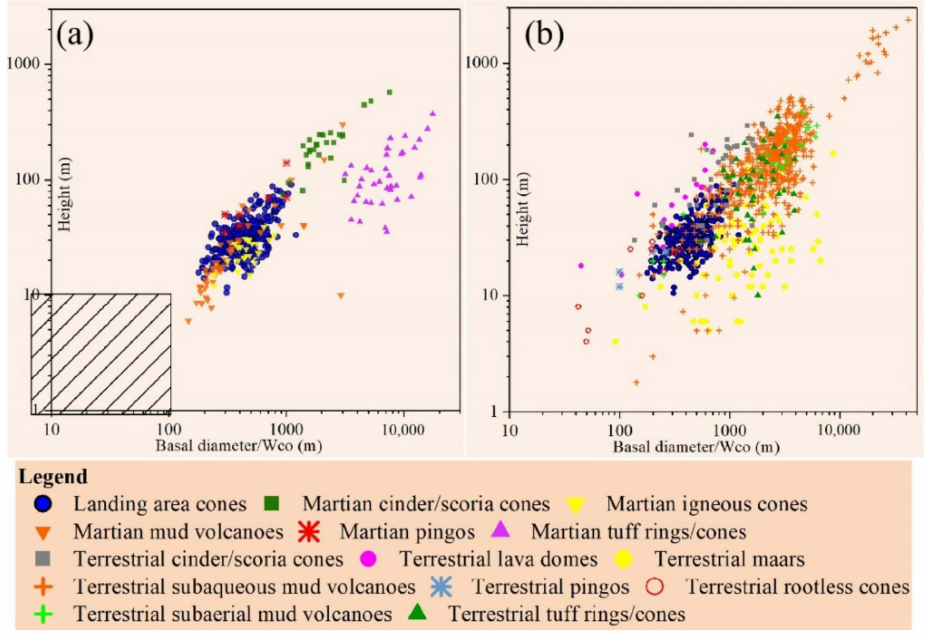
Figure 5. Log-log plots showing cone heights (Hco) versus basal diameters (Wco). All of the data are from previous studies, including Martian cinder/scoria cone [10], Martian igneous cone [40], Martian mud volcanoes [3,4], Martian pingos [52], Martian tuff rings/cones [7], terrestrial cin- der/scoria cones [53–55], terrestrial lava domes [54], terrestrial maars [54], terrestrial subaqueous mud volcanoes [56,57], terrestrial pingos [52], terrestrial rootless cones [54], terrestrial subaerial mud volcanoes [7,58], and terrestrial tuff rings/cones [54]. ( a ) Morphometric comparison between the stud- ied cones and the features on Mars. The bottom left rectangle with filled diagonals represents Martian rootless cones that were acquired from [12] (Wco: 2.7–105.6 m, Hco: 0.3–10.52 m). ( b ) Morphometric comparison between the studied cones and the features on Earth. A series of separate panels are provided in Figure S1 in Supplementary Materials to complement this figure for better